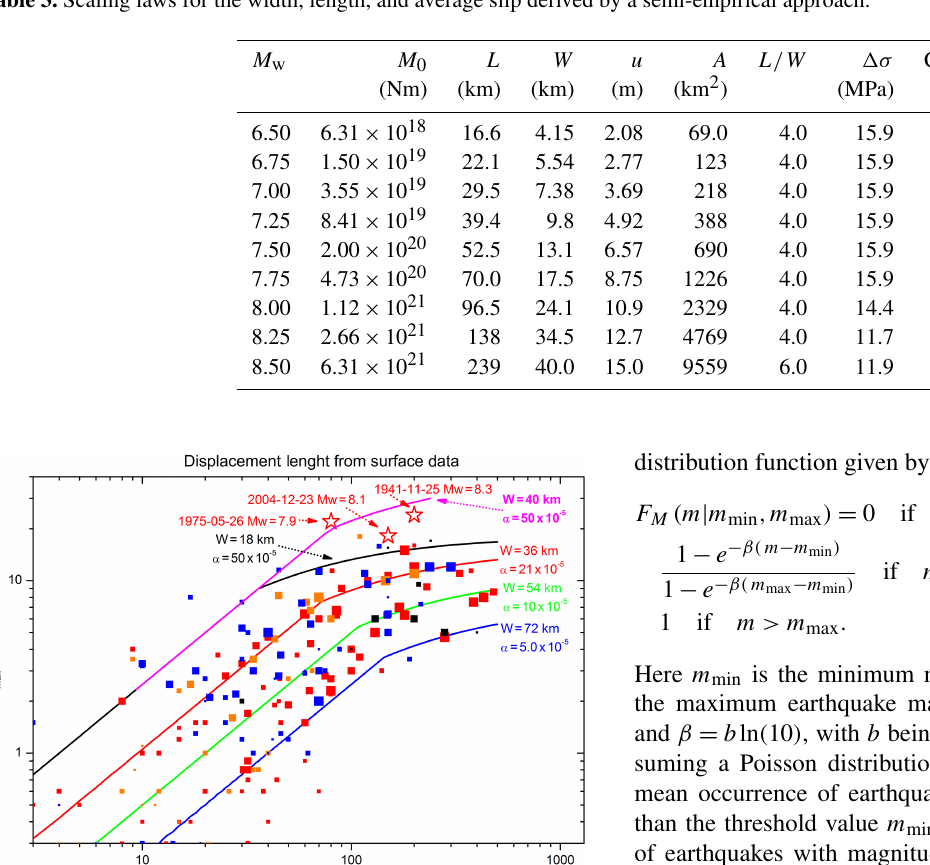
Table 3. Scaling laws for the width, length, and average slip derived by a semi-empirical approach.